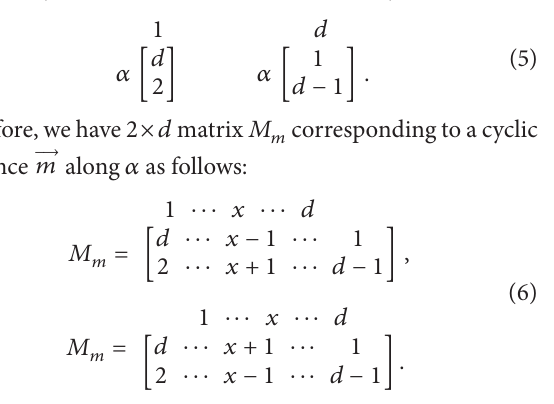
3. The Dual and Mirror Images of 𝐷(𝑎, 𝑏, 𝑐,